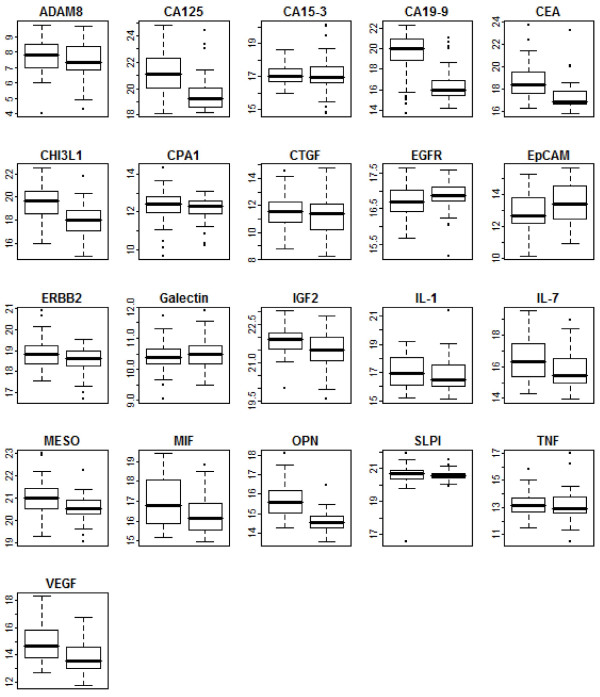
Plasma levels of 21 tumor markers in pancreatic cancer patients and healthy controls measured by proximity ligation assay. Each boxplot corresponds to a single tumor marker measured in 95 samples by proximity ligation assay. Pancreatic cancer cases (52) are depicted at left, healthy controls (43) at right. Y-axis corresponds to log2 PLA units. Central bars show the median for each cohort, boxes represent the interquartile 50th percentile (IQ50). Whiskers represent 1.5 times the IQ50.